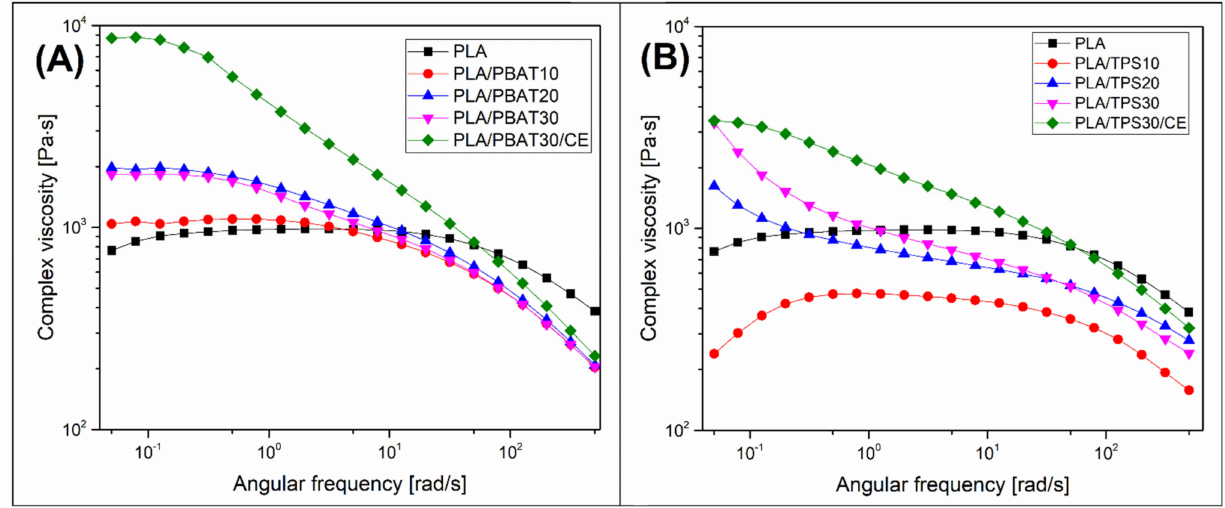
Figure 6. The results of the small amplitude oscillation shear tests for ( A ) PLA/PBAT-based blends and ( B ) PLA/TPS